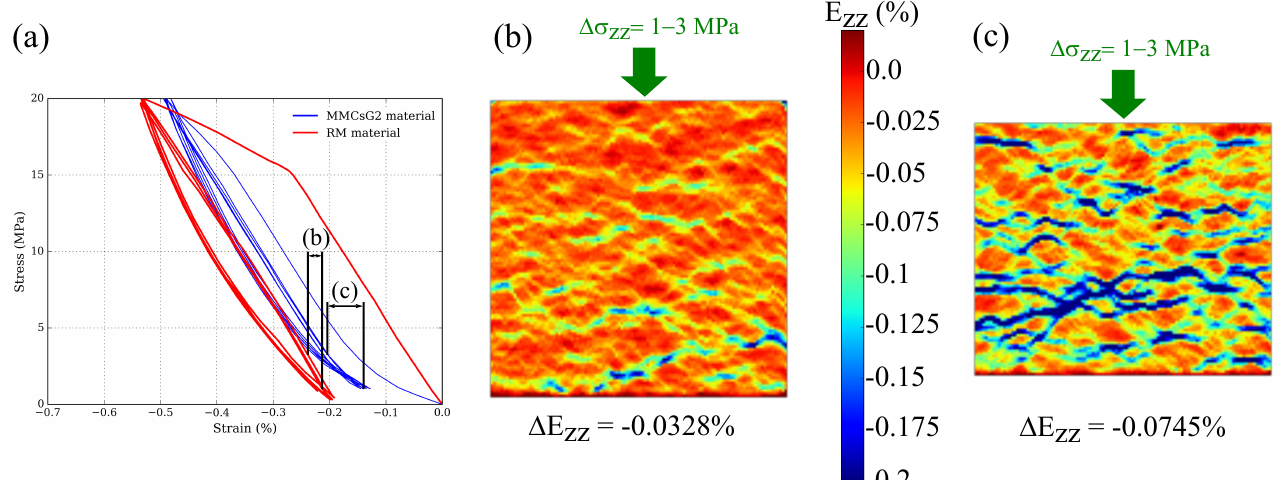
Figure 8. ( a ) Compressive stress-strain (E zz ) curves of RM and MMCsG2 materials. ( b ) DIC E zz image of the RM corresponding to the ∆ σ = 1–3 MPa loading within the loops. ( c ) DIC E zz image of the MMCsG2 material corresponding to the ∆ σ = 1–3 MPa loading within the